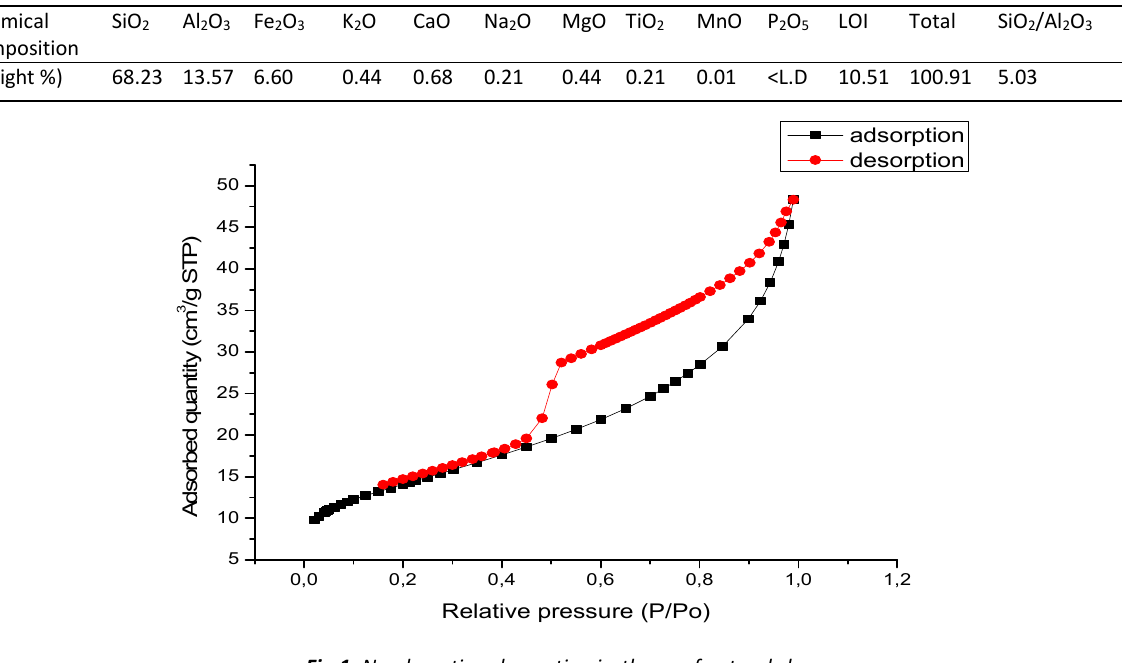
Fig.1. N 2 adsorption-desorption isotherm of natural clay